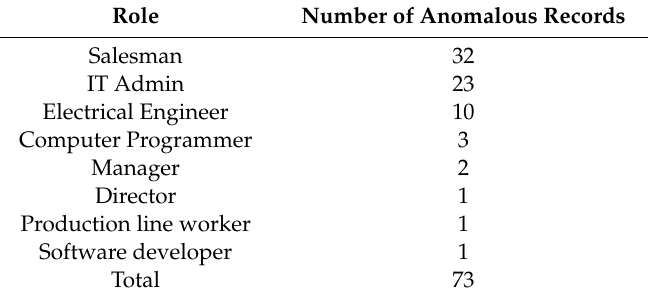
Table 3. The number of anomalous records according to role.